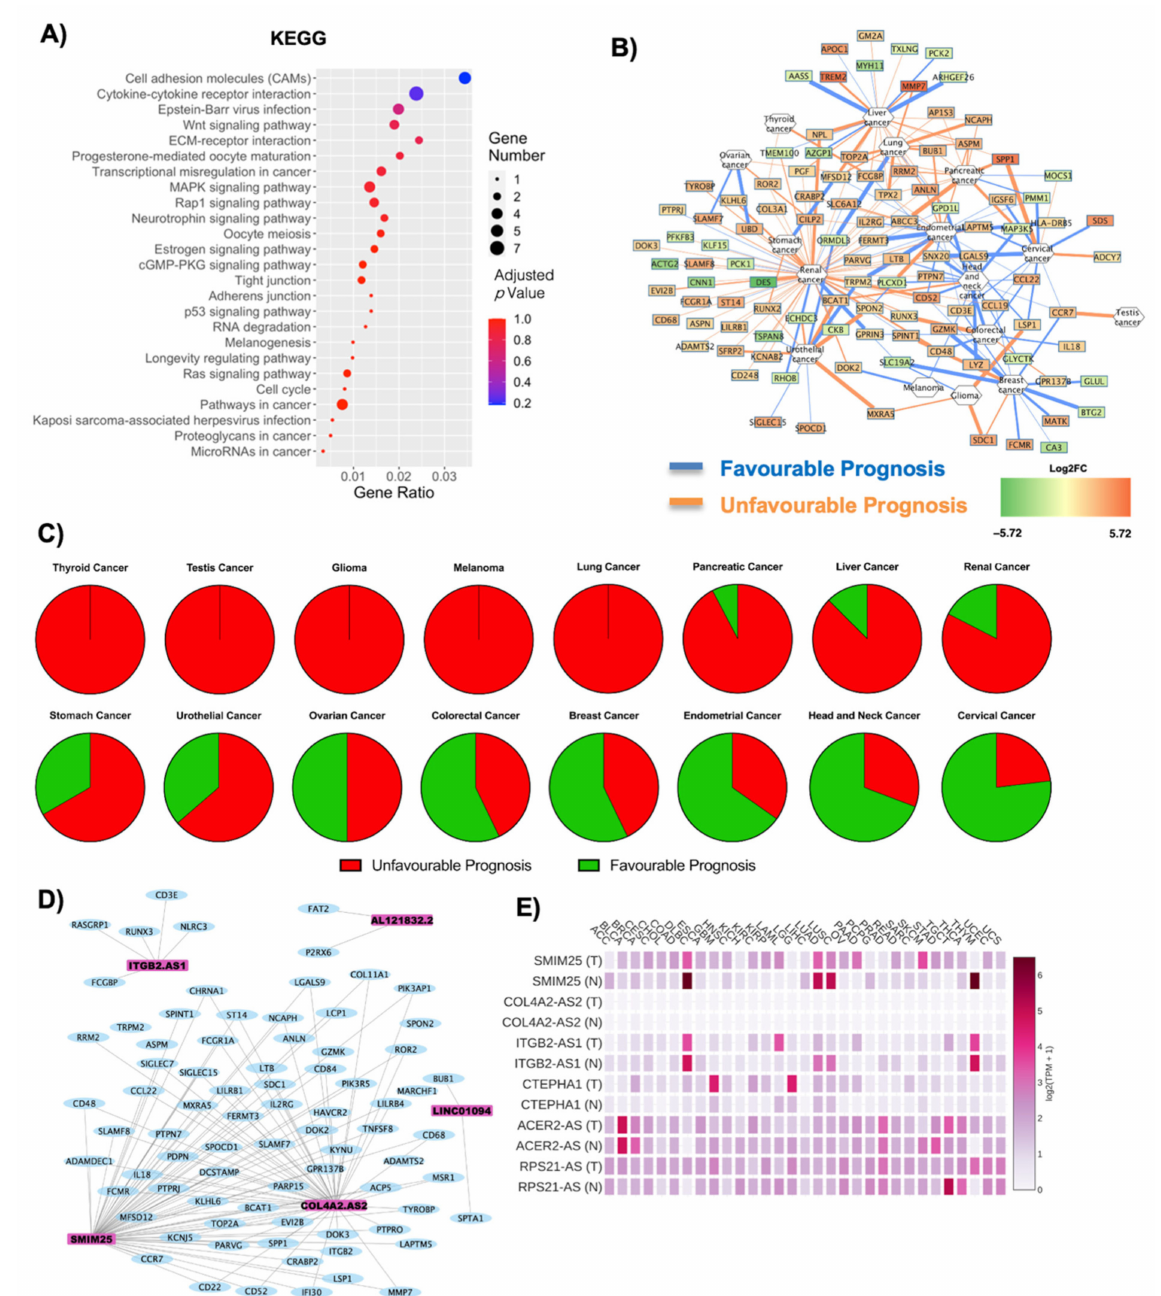
Figure 3. Cancer and oncogene correlations in OBF vs. CTRL conditions. ( A ) Dotplot of deregulated oncogenic pathways from KEGG analysis. The y-axis represents the name of the pathway, the x-axis represents the gene ratio, dot size represents the number of different genes and the color indicates the adjusted p -value. ( B ) Relationship between DE RNAs and the possibility of a cancer diagnosis. Nodes are DE RNAs and are ranked according to fold change whereas edges indicate disease prognosis and are colored according to favorable (light blue) and unfavorable (orange) prognosis. ( C ) Pie graph displays the overall unfavorable or favorable prognosis. ( D ) Co-interaction network between lncRNAs in OBF vs. CTRL and the oncogenes highlighted after OncoScore analysis. Light blue nodes are coding genes whereas pink nodes are lncRNAs. The coding and non-coding RNAs form 4 main networks of interaction, the largest of which includes both COL4A2-AS2 and SMIM25. On the contrary, ITGB2-AS1, LINC0194 (CTEPHA1) and AL121832.2 (RPS21-AS) formed each one separate interaction network. ( E ) The GEPIA2 database displays the specific annotated expression of each lncRNA in tumoral and normal